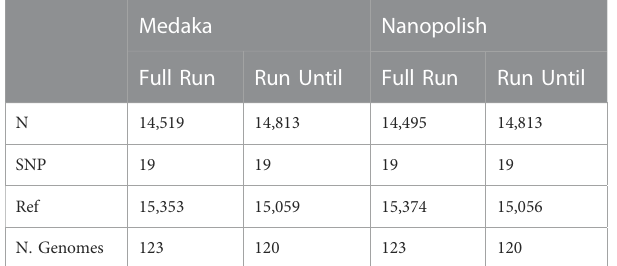
TABLE 3 Contingency table displaying the mean count for sites called as either reference (Ref),SNPorunknown (N).Note,Thetotal ofeachcolumn, excluding (N. genomes) represents every position in a SARS-CoV-2 genome. Only genomes NOT present in the Sample completed category are included in the analysis.